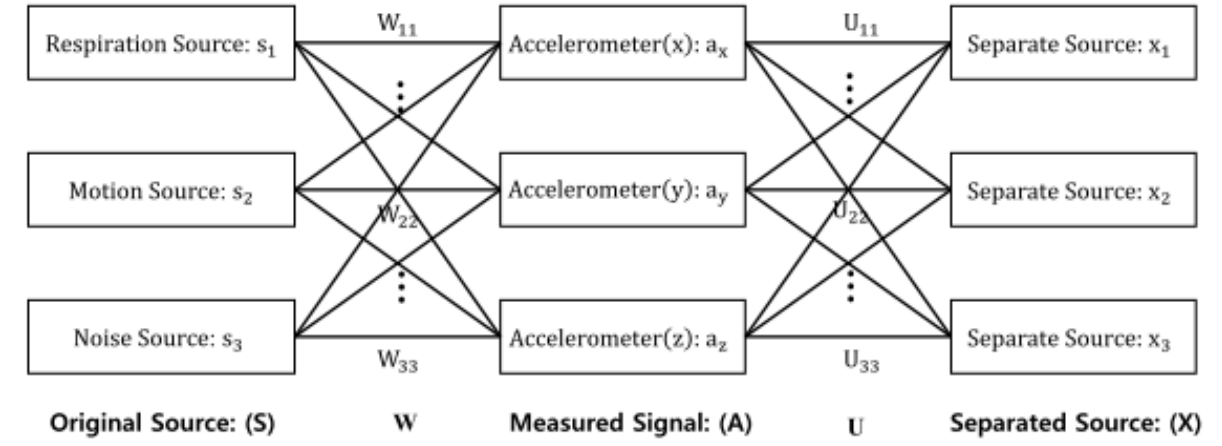
Figure 3. Independent component analysis model for respiration